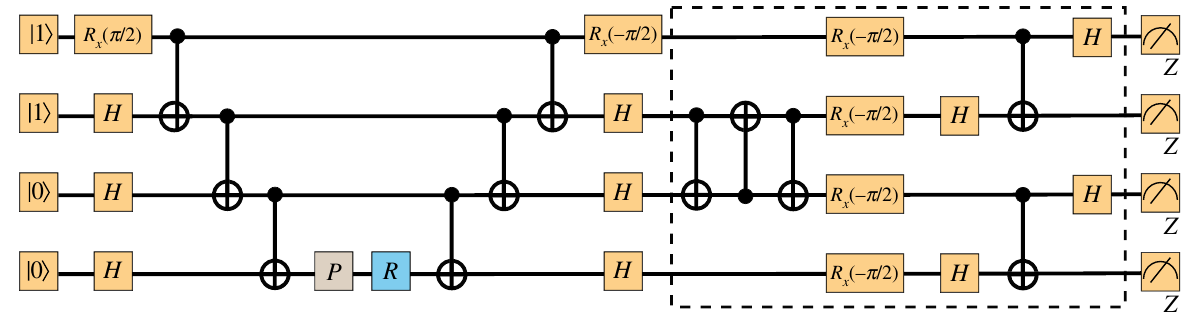
FIG. 12. Circuit used in the error-mitigated variational quantum eigensolver. The gates R x (φ) = e − i φ X / 2 . can be measured using the same circuit. We use Qiskit to calculate the coefficients in